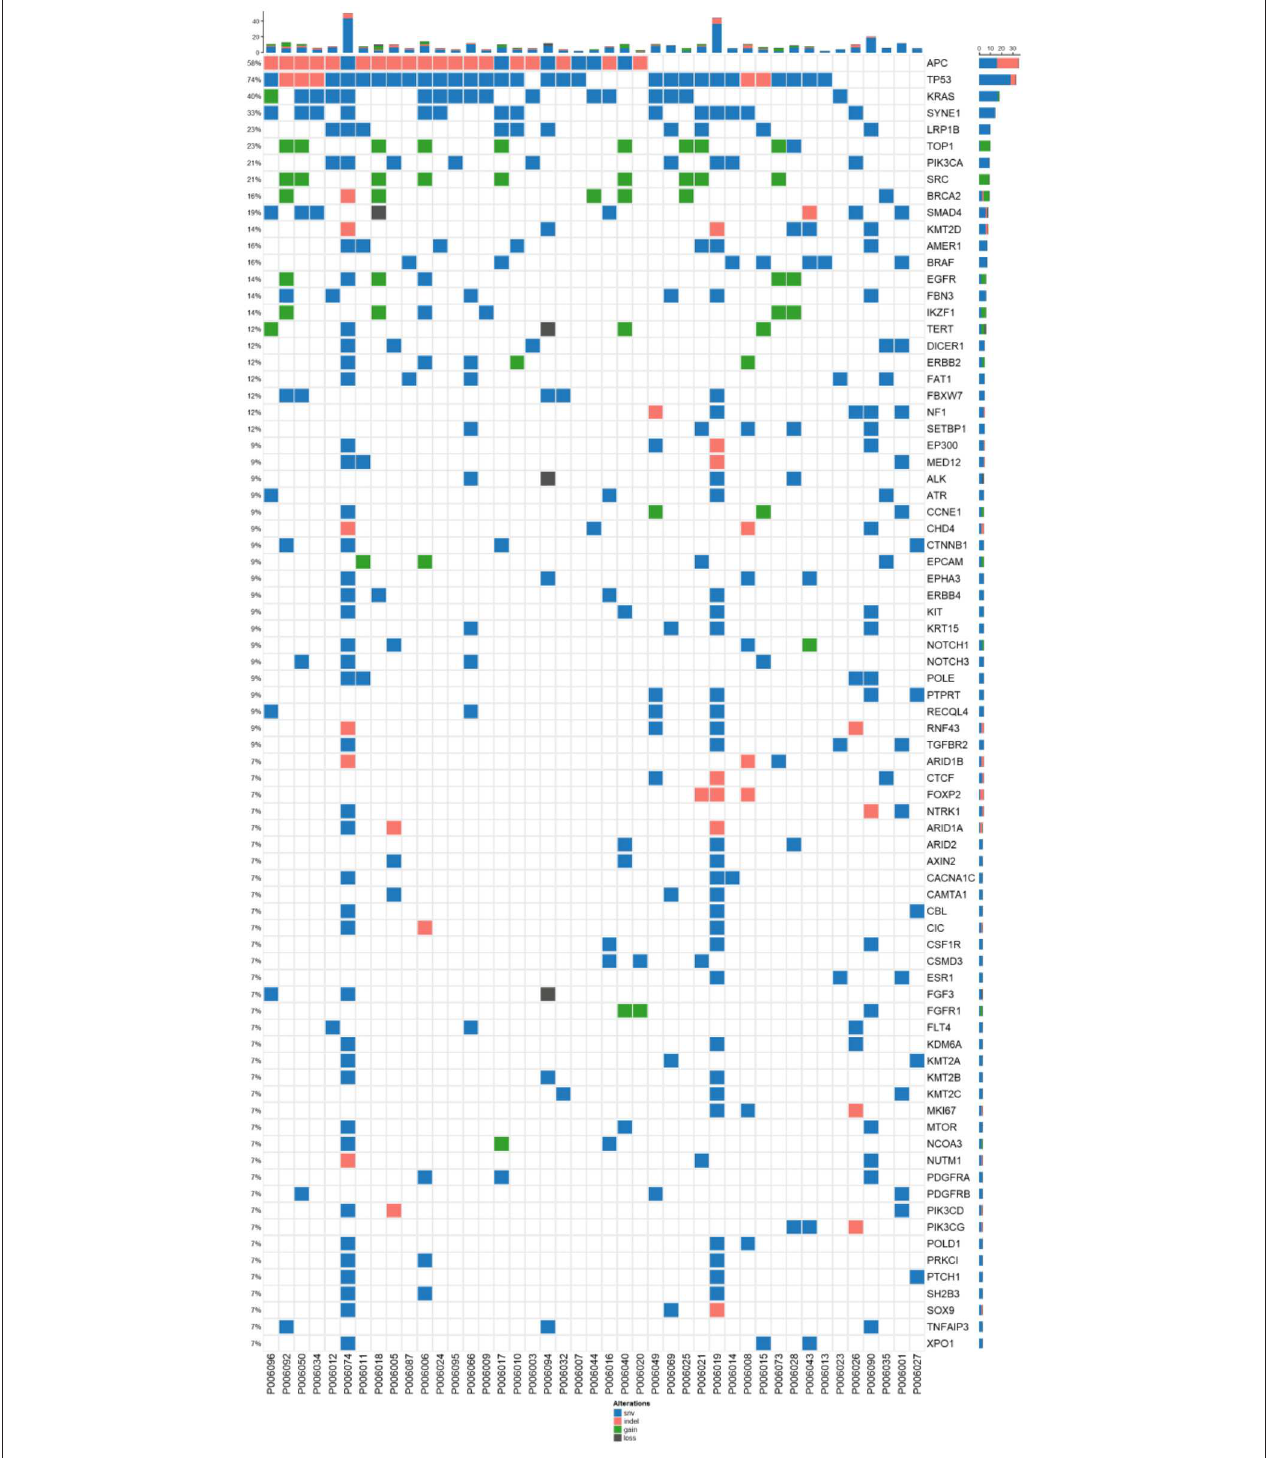
FIGURE 1 | Mutation spectrum of baseline plasma and tissue samples from 43 patients CRC. The genes with a high mutation frequency among all patients are listed on the left and individual patients are represented by the columns. Mutation types of non-synonymous single nucleotide variant, SNV (single nucleotide variant), indel (insertion-deletion), gain(stop gain, non-sense mutation), and loss(stop loss, missense mutation) are represented by blue, orange, and dark, respectively.